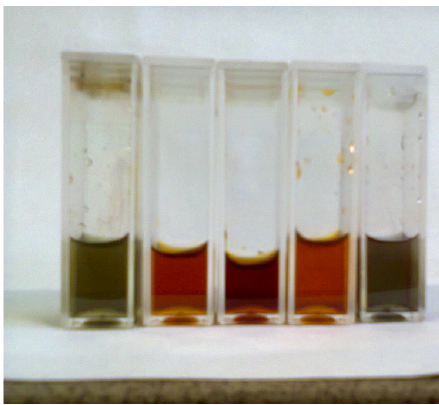
Figure 1 : Solutions of silver nanoparticles at different